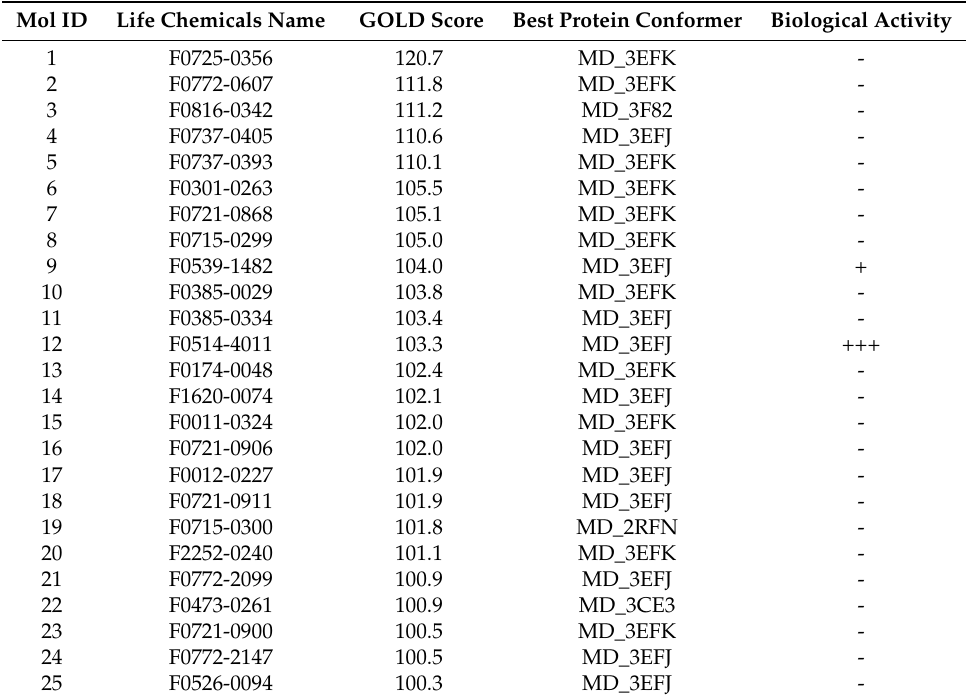
Table 6. Ligands selected from the Life Chemical (LC) antiviral library and experimentally tested. ”-“: the compound (assessed at a concentration up to 100 µ M) did not affect MDCK cell scattering in response to HGF/SF. ”+“: the compound impaired MDCK cell scattering in response to HGF/SF with an IC 50 > 10 µ M. ”+++“: the compound impaired MDCK cell scattering in response to HGF/SF with an IC 50 < 10 µ M. Mol